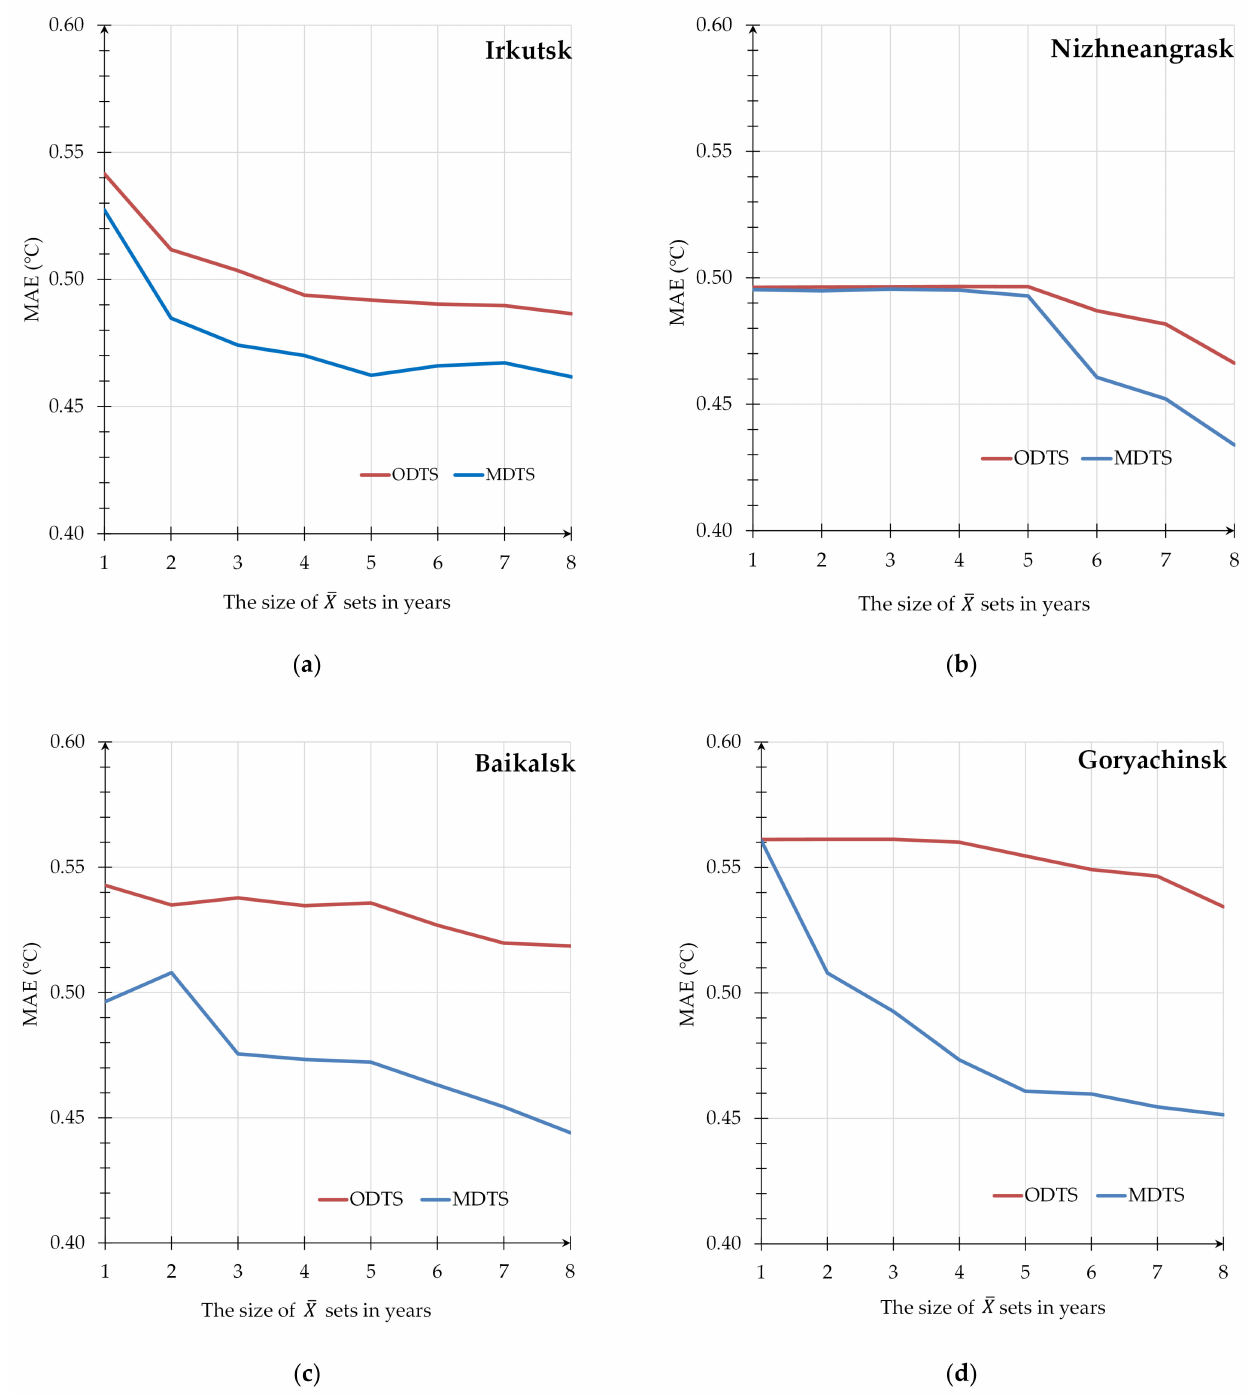
Figure 5. Prediction based on the ODTS and MDTS of the air temperature for Irkutsk ( a ), Nizhnean- garsk ( b ), Baikalsk ( c ), and Goryachinsk ( d